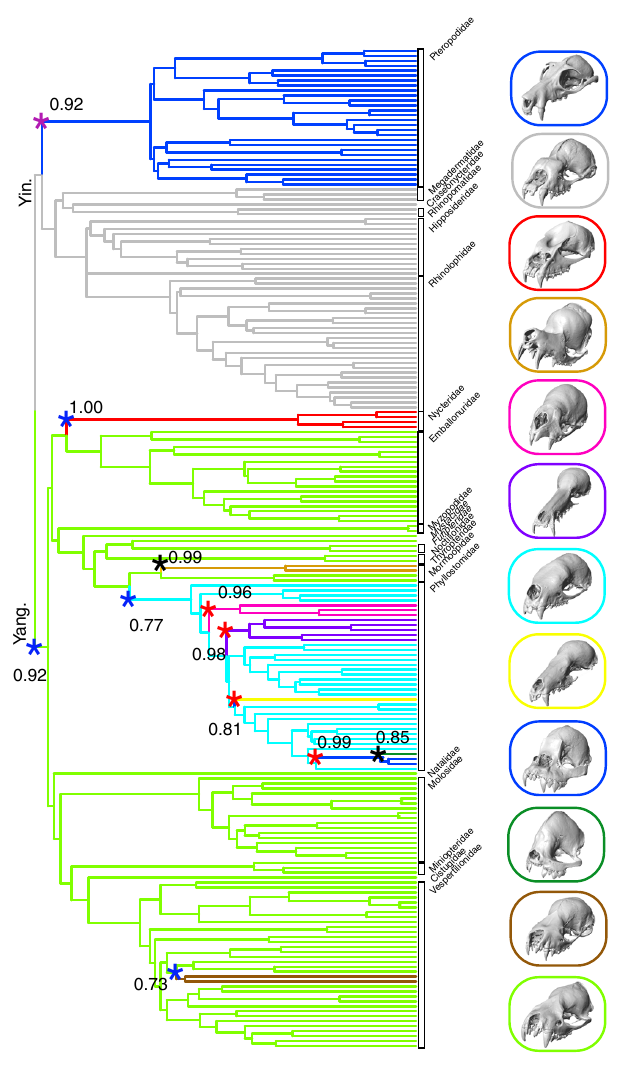
Fig. 4 Evolutionary shifts (asterisks) in cranium shape across bats. Shifts were determined by l1ou adaptive landscape model fi tting on pPCA scores using pBIC (pPC 1 – 3; Fig. 1). Bootstrap support is given for shift locations. Blue shifts = transition in echolocation type, Red shifts = transitions in diet, Purple shifts = transition in echolocation type and diet, Black shifts = no transition. Digital models of crania from μ CT data illustrate the sample taxa from each adaptive regime, 3D models were visualized using Checkpoint. Representative taxa, from top to bottom: Pteropus poliocephalus, Hipposideros caffer, Nycteris hispida, Mormoops blainvillei, Desmodus rotundus, Choeronycteris mexicana, Phylloderma stenops, Ametrida centurio, Centurio senex, Corynorhinus townsendii, Murina leucogaster . Yin. = Yinpterochiroptera. Yang. = Yangochiroptera the base of Desmodontinae (sanguinivores), Glossophaginae and Lonchophyllinae (nectarivores), and within the Stenodermatinae clade of Centurio + Ametrida + Sphaeronycteris (durophagous frugivores; and see Supplementary Fig. 6 for subfamilies).